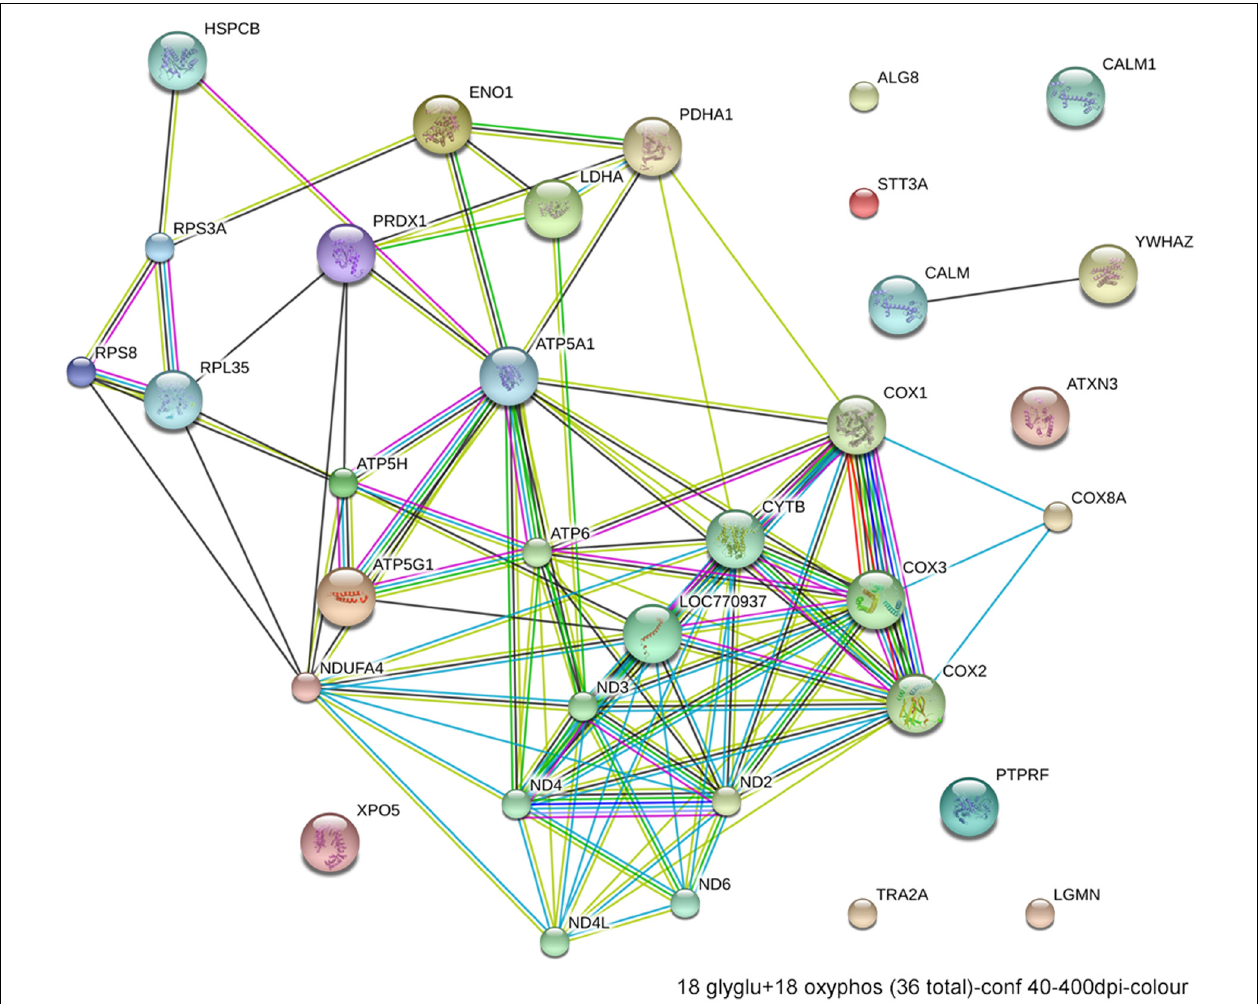
FIGURE 6 | Network interactions from DAVID depict the relationships between the 18 glycolytic and 18 oxidative phosphorylation genes that have significantly different expression between ethanol-sensitiveW98S and ethanol-resistantW98D neural